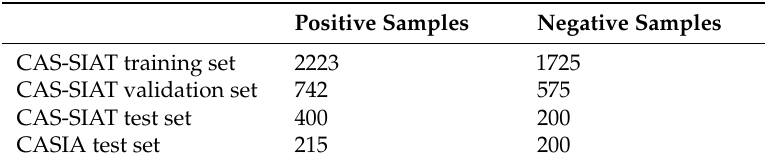
Table 1. Data distribution in a person-disjoint manner for the network trained with CAS-SIAT-Iris dataset and tested with both